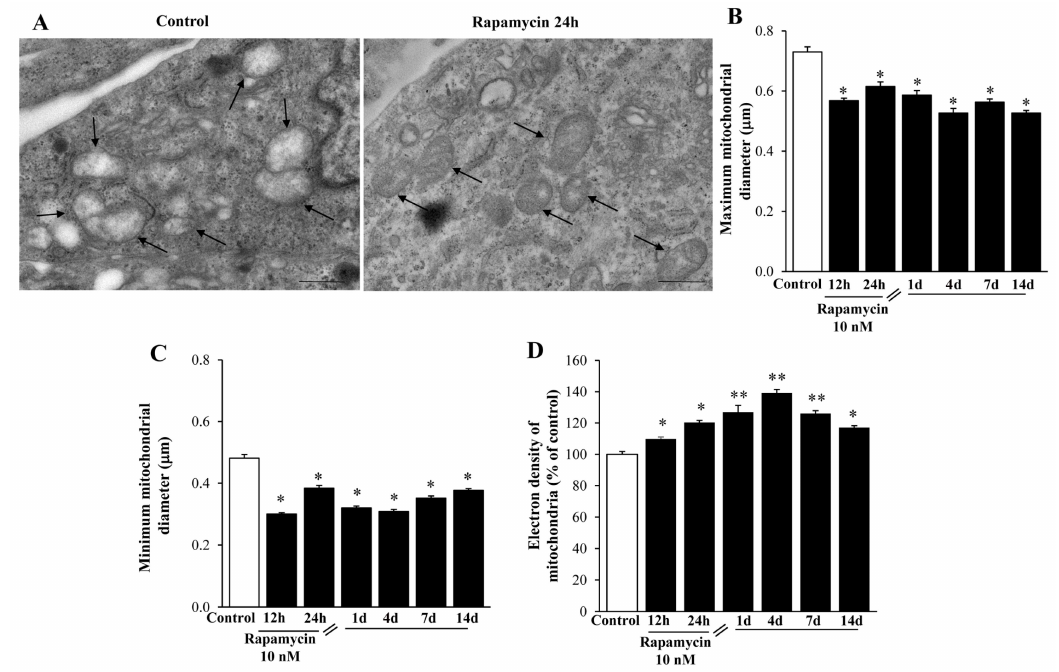
Figure 8. Rapamycin re-shapes mitochondria within U87MG cells at di ff erent time intervals. ( A ) Representative TEM micrographs showing mitochondria (arrows) from Control and following 10 nM rapamycin at 24 h. Graphs ( B , C , D ) confirm that reported in Figure 7 after rapamycin withdrawal from 1 d up 14 d. In fact, both the maximum ( B ) and minimum ( C ) mitochondrial diameter were decreased, whereas the mitochondrial electron density ( D ), which is expressed as a percentage of mitochondrial electron-density measured from Control, was increased. Values were obtained from 100 or 250 mitochondria per group. * p ≤ 0.05 vs. Control; ** p ≤ 0 05 vs. Control and 12 h. Scale bar = 0.56 µ